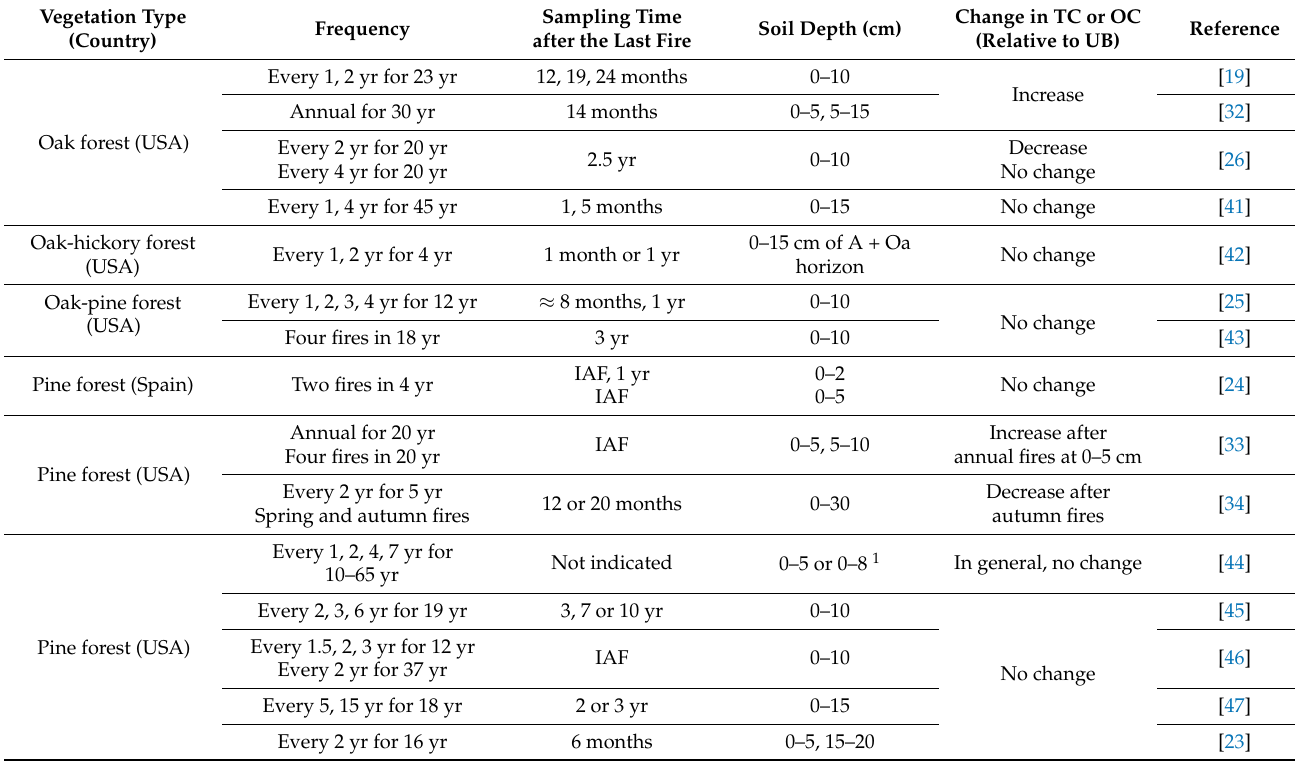
Table 2. Studies including the effects of repeated prescribed fires on soil total or organic carbon (TC, OC). UB: unburned soil; yr: year; IAF: immediately after